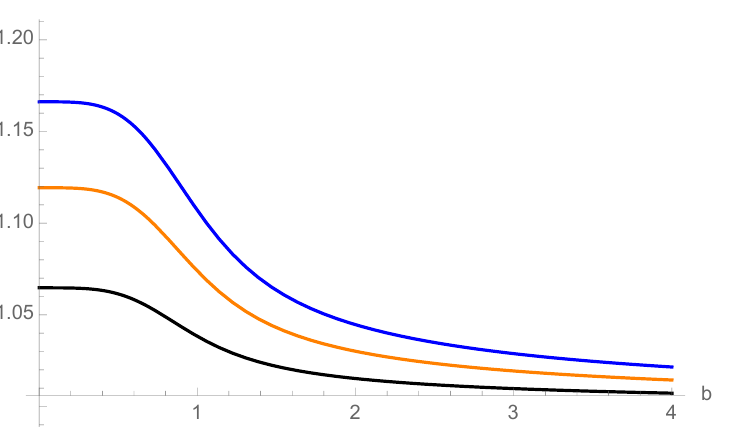
Figure 6 . The vertical axis is the ratio between the local maximum and the asymptotic late time value of the complexi(cid:12)cation rate. The black, orange and blue curves correspond to (cid:13) = 1 ; 2 ; 3. it is not true, because the local maximum always exists, but has a diminishing relative height and is pushed to very late time. We can (cid:12)nd the local maximum and plot its ratio to the asymptotic value versus b as in (cid:12)gure 6. The fact that the local maximum decays physically rather than by tuning some arti(cid:12)cial choice is a sign that the noncommutative complexi(cid:12)cation rate at late time is a more quali(cid:12)ed bound for a generic quantum